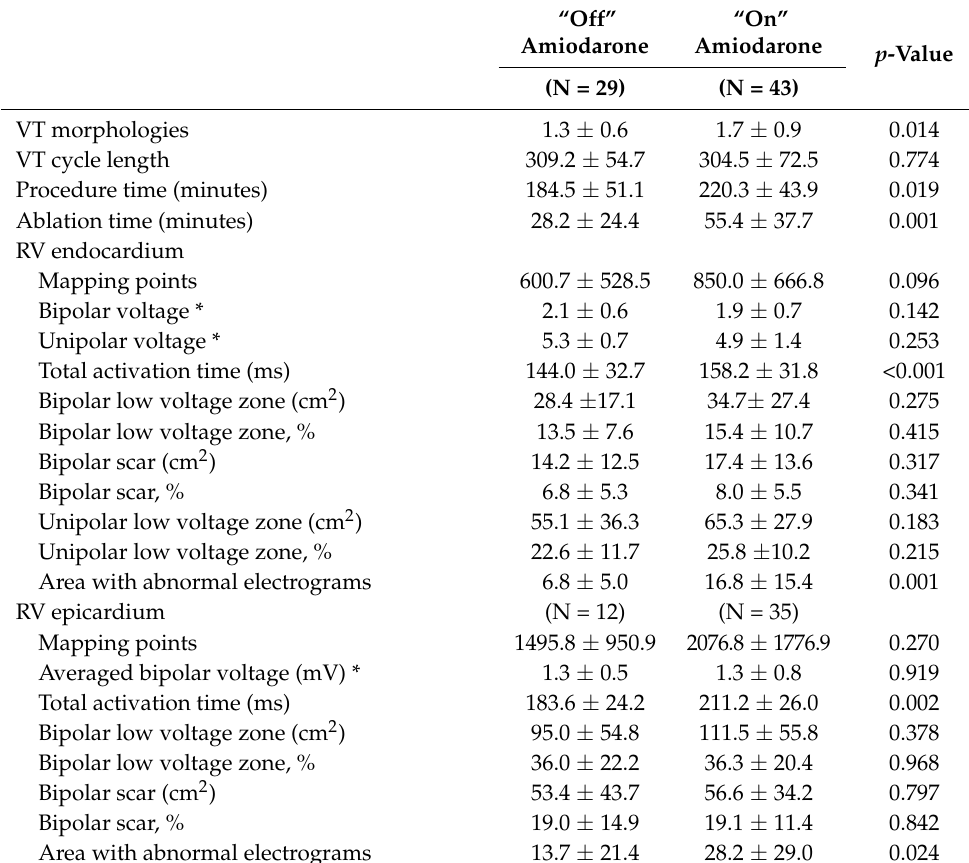
Table 2. Comparison of baseline characteristics between patients with ARVC “On” and “Off” amio- darone before ablation.